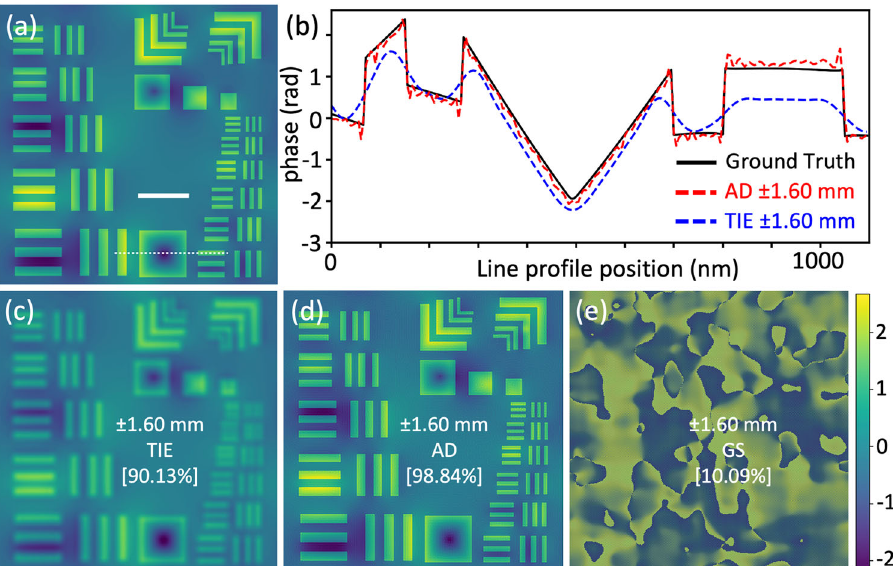
Fig. 2 Comparative performance on simulated noise free images. a Ground truth for the phase. The scale bar is 500 nm. b Comparison between the line pro fi les of the ( c ) TIE and ( d ) AD retrieved phases using an image pair at Δ f = ±1.6 mm. The position at which the line pro fi les are extracted is illustrated by the dotted line in ( a ). e GS retrieved phase using the same image pair. The numbers in the brackets denotes the accuracy of the retrieved phases. The scale bar and the color bar apply to all the